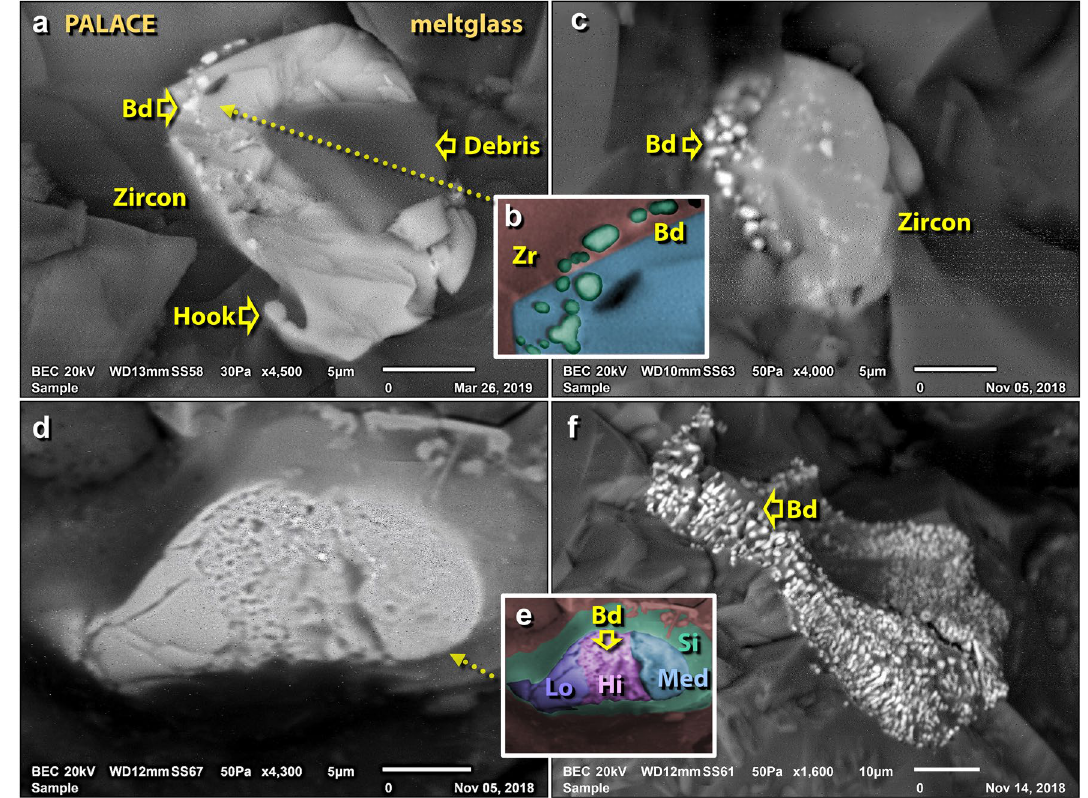
Figure 32. SEM images of melted zircon grains in mudbrick meltglass from the palace. ( a ) Thermally distorted zircon grain with a “hook” that resulted from the flow of molten material at > 1687 °C; the darker area represents unrelated debris on top of zircon. ( b ) Manually constructed EDS-based phase map showing baddeleyite grains (Bd = ZrO 2 ) in green, zircon in blue, and melted mudbrick in red. ( c ) Zircon grain showing limited thermal alteration, yet sufficient to cause dissociation into bright baddeleyite grains at ~ 1676 °C. ( d ) Zircon grain exhibiting three phases of thermal alteration, as shown in detail in ( e ), where a manually constructed EDS-based phase map demonstrates that high temperatures caused bubbling in the center band of zircon (purple = Hi) producing sub-micron-sized grains of baddeleyite (e.g., at arrow). Medium temperatures caused zircon to melt and flow (blue = Lo), and lower temperatures at the left end of grain produced thermal cracks (medium blue = Med). The green area marks the high-Si diffusion zone resulting from the dissociation of zircon. ( f ) Zircon grain from TeH has been fully converted to granular